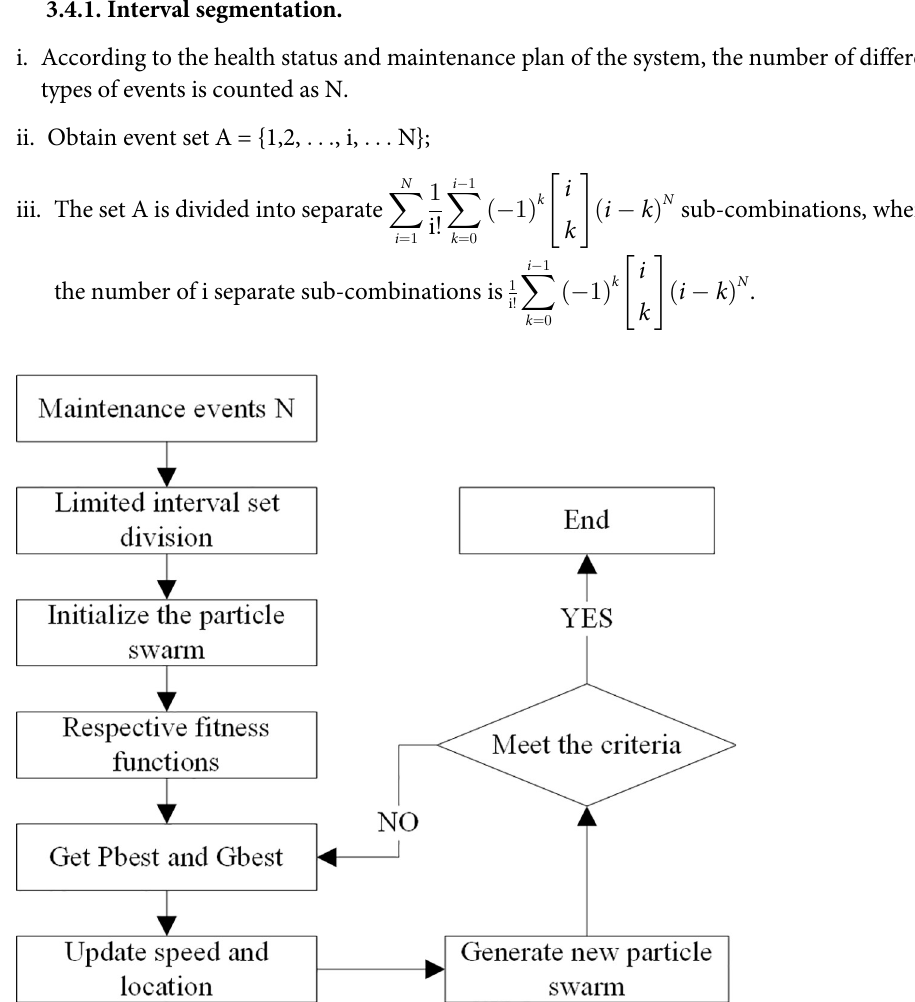
Fig 6. A particle swarm optimization algorithm flow based on interval